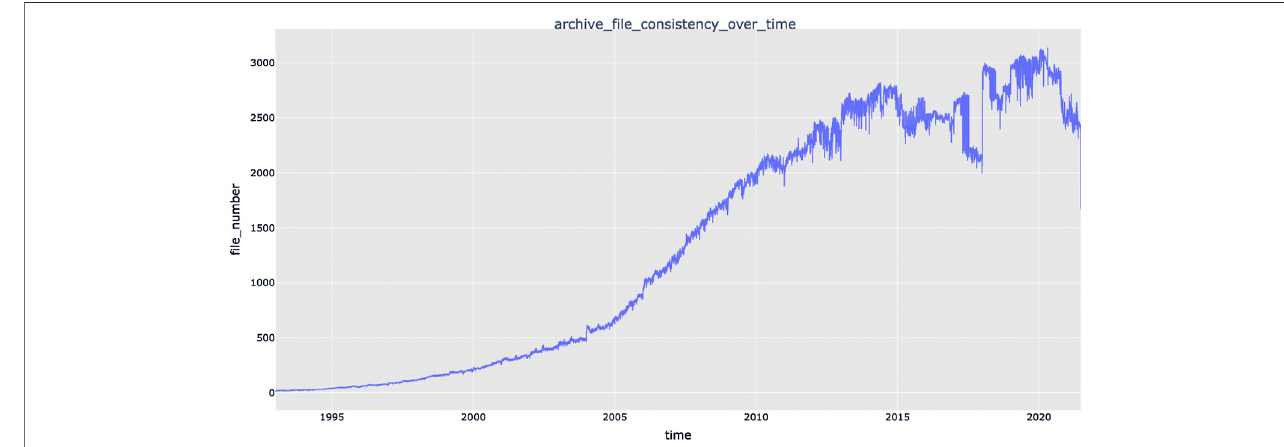
FIGURE 2 | Temporal evolution of the number of RINEX fi les archived from 1996 to the end of April 2021.